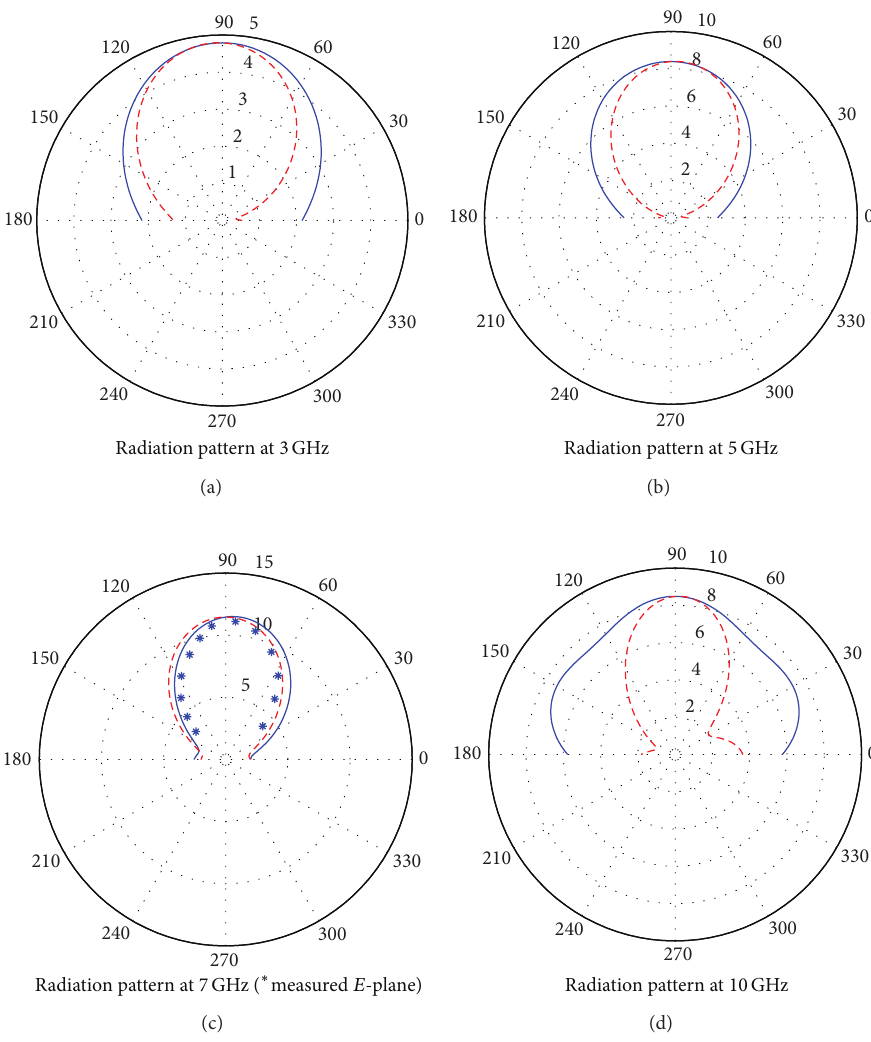
Figure 5: Simulated E and H-plane radiation patterns for 3, 5, 7, and 10GHz and experimental E-plane radiation pattern for 7GHz signal (“ ∗